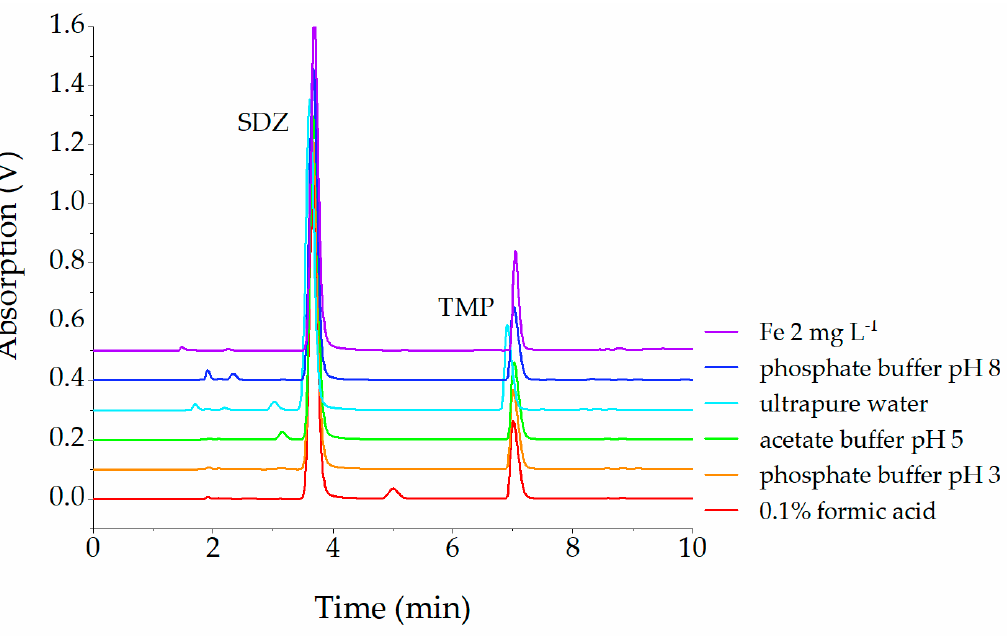
Figure 1. Stacked UV-chromatogram sections of various solutions of SDZ and TMP recorded at 270